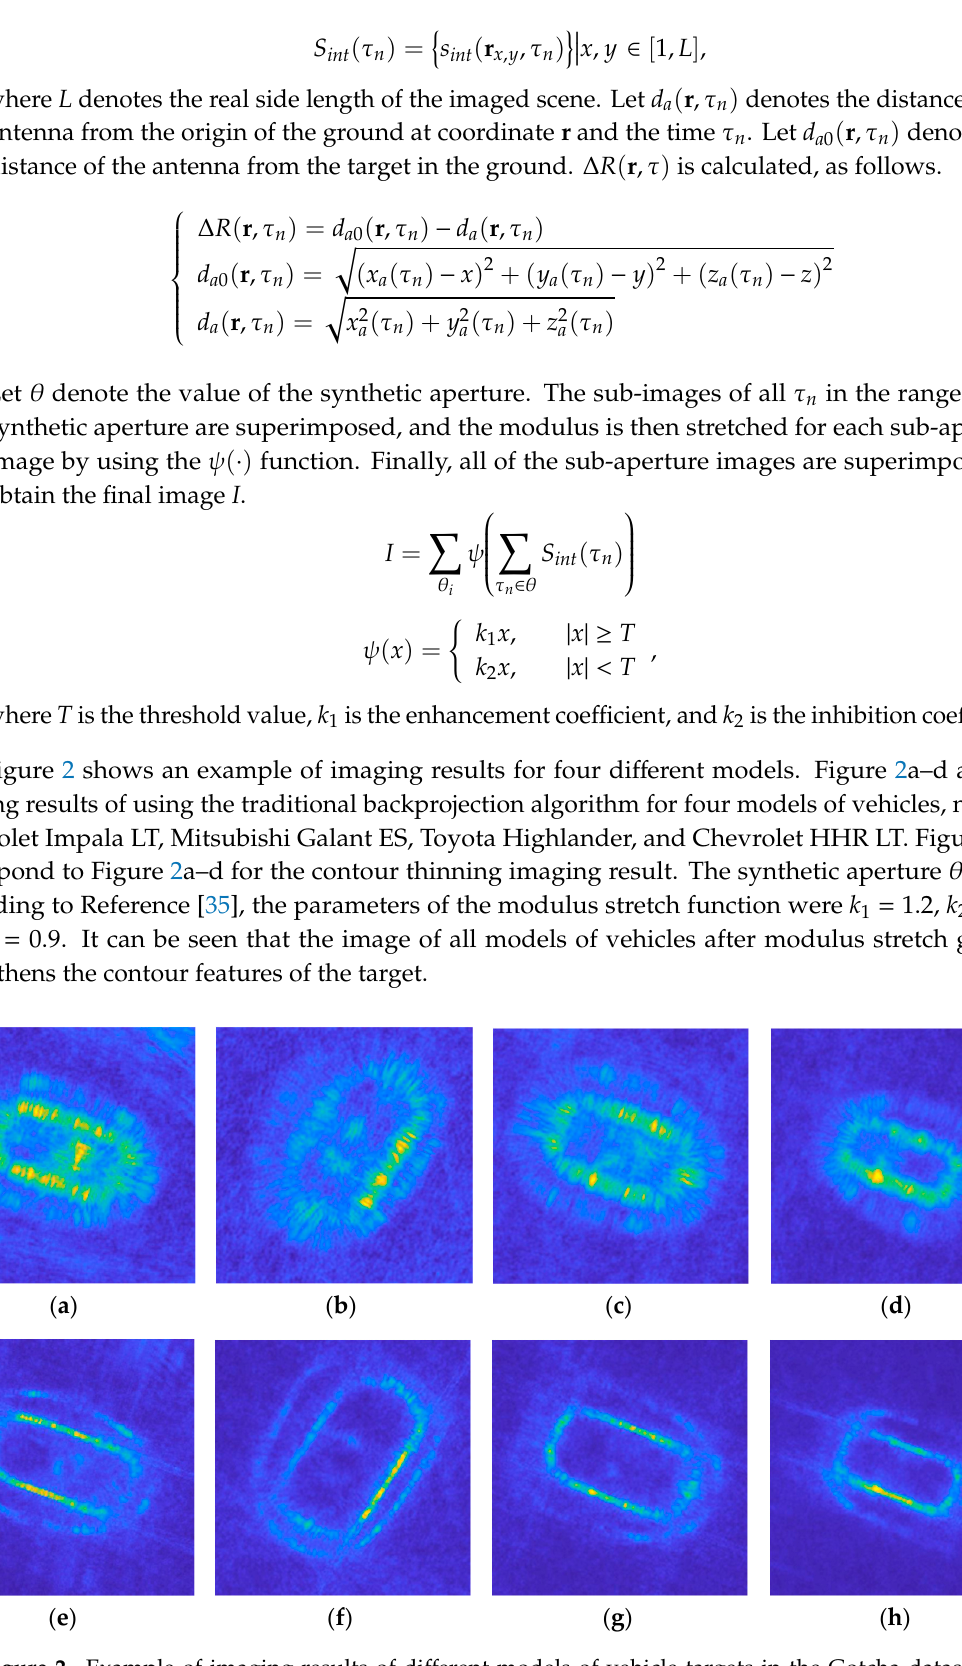
Figure 2. Example of imaging results of different models of vehicle targets in the Gotcha dataset by contour thinning imaging: ( a , e ) Chevrolet Impala LT; ( b , f ) Mitsubishi Galant ES; ( c , g ) Toyota Highlander; and, ( d , h ) Chevrolet HHR LT.